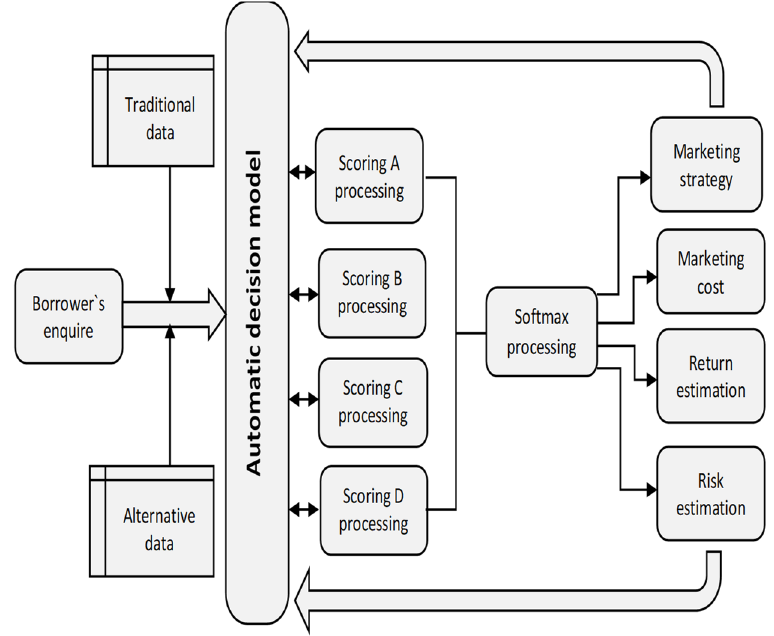
Figure 8. Conceptual scheme of functioning short-term